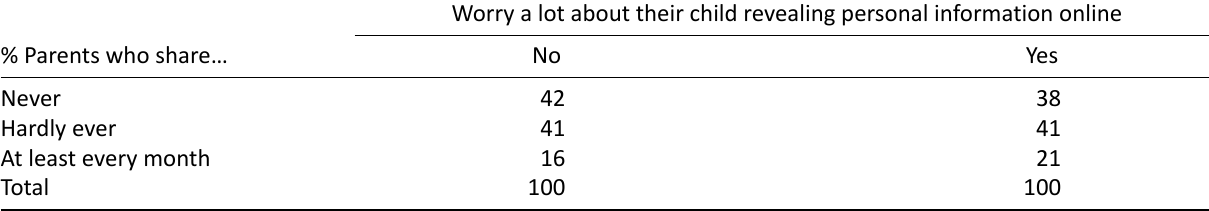
Table 3. How often do you share/post/blog photos/videos of your child online? By whether or not parents are worried about their child revealing personal information online. Worry a lot about their child revealing personal information online